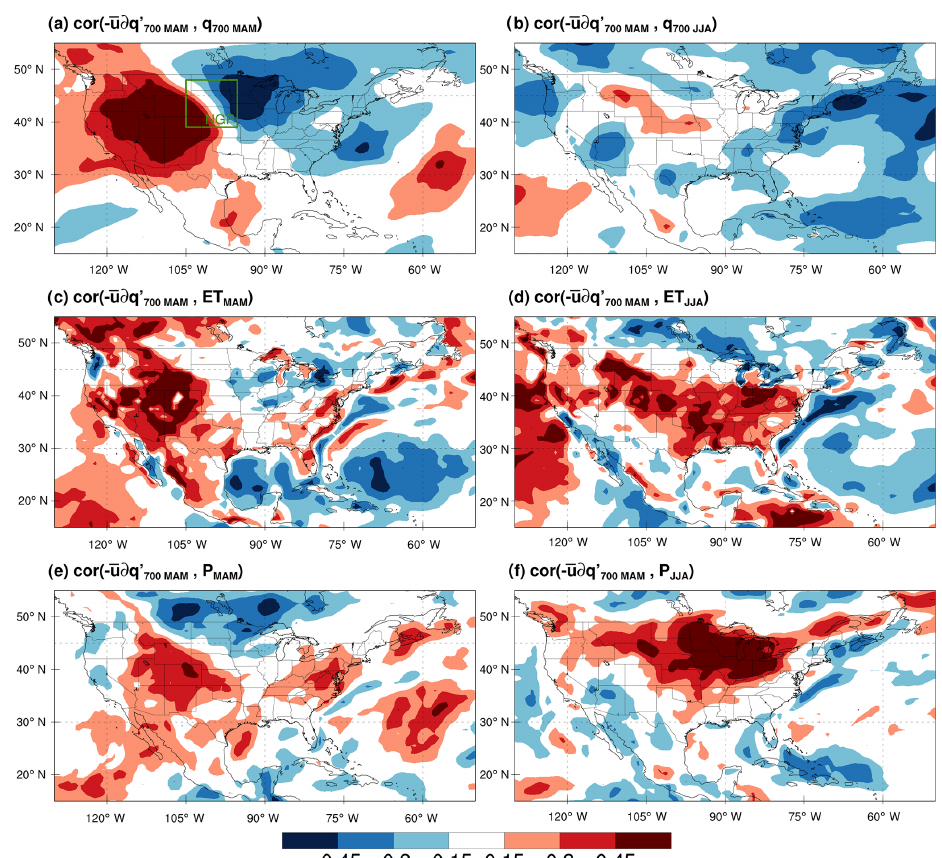
Figure 11. Same as Fig. 10 but for the